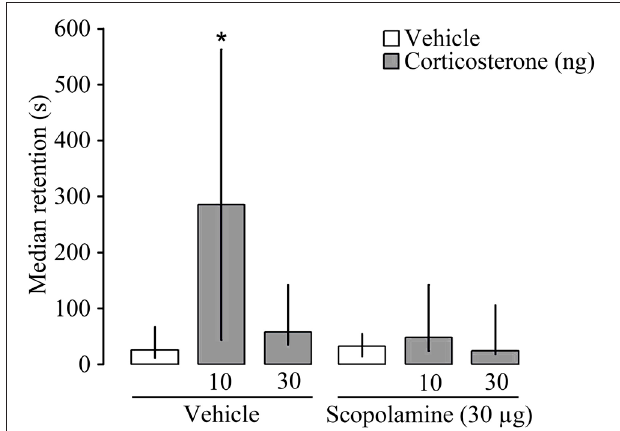
FIGURE 4 | Median latencies and interquartile ranges, in seconds on the 48h inhibitory avoidance retention test. The muscarinic receptor antagonist scopolamine (30 μ g) administered into the dorsal striatum immediately after inhibitory avoidance training blocked the memory-enhancing effect of concurrently administered corticosterone ∗ P < 0 . 05 as compared to the vehicle group ( N = 8–11